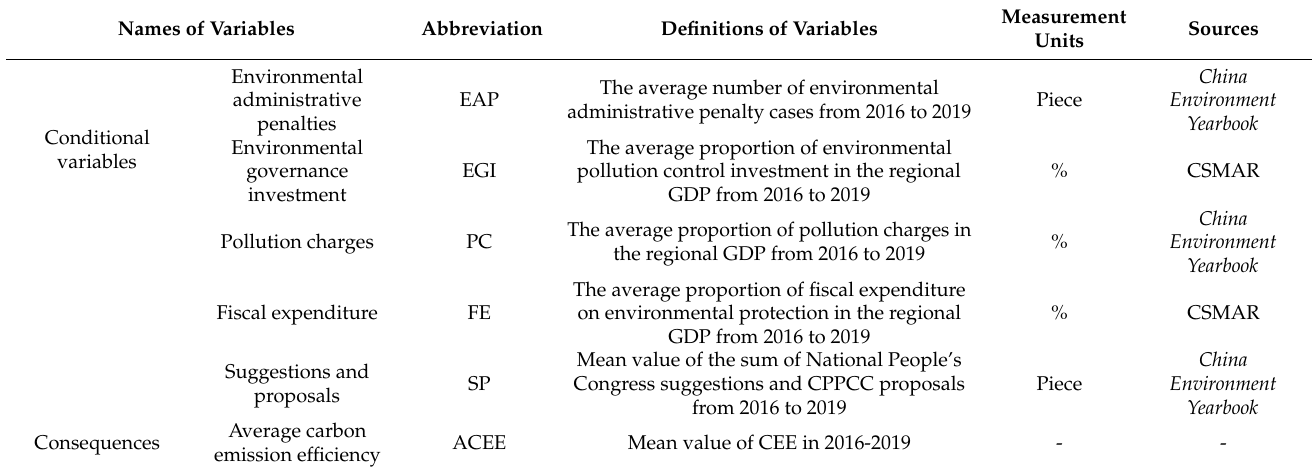
Table 2. Definitions and sources of the